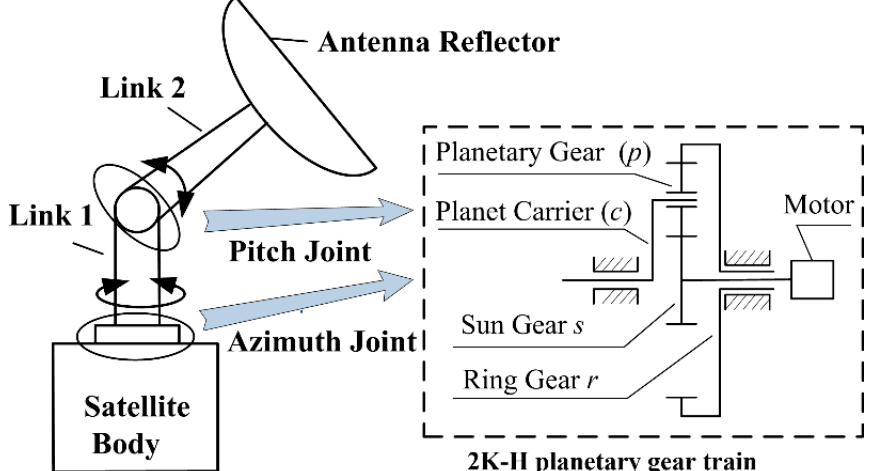
Figure 1. Simplification of the dual-axis driving mechanism for satellite antenna.